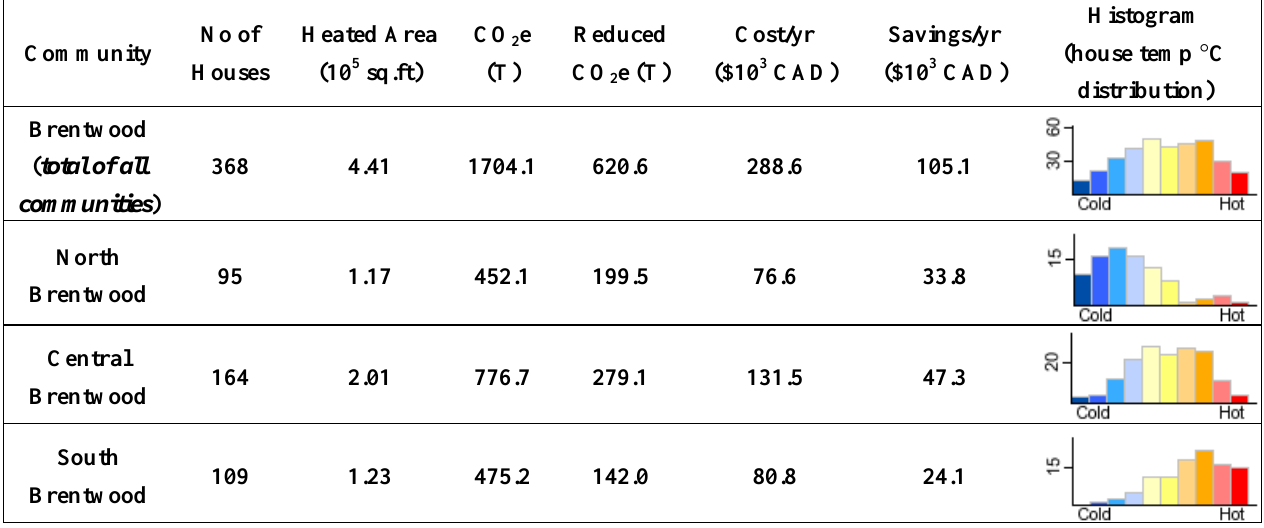
Table 1. Summary of Community Waste Heat